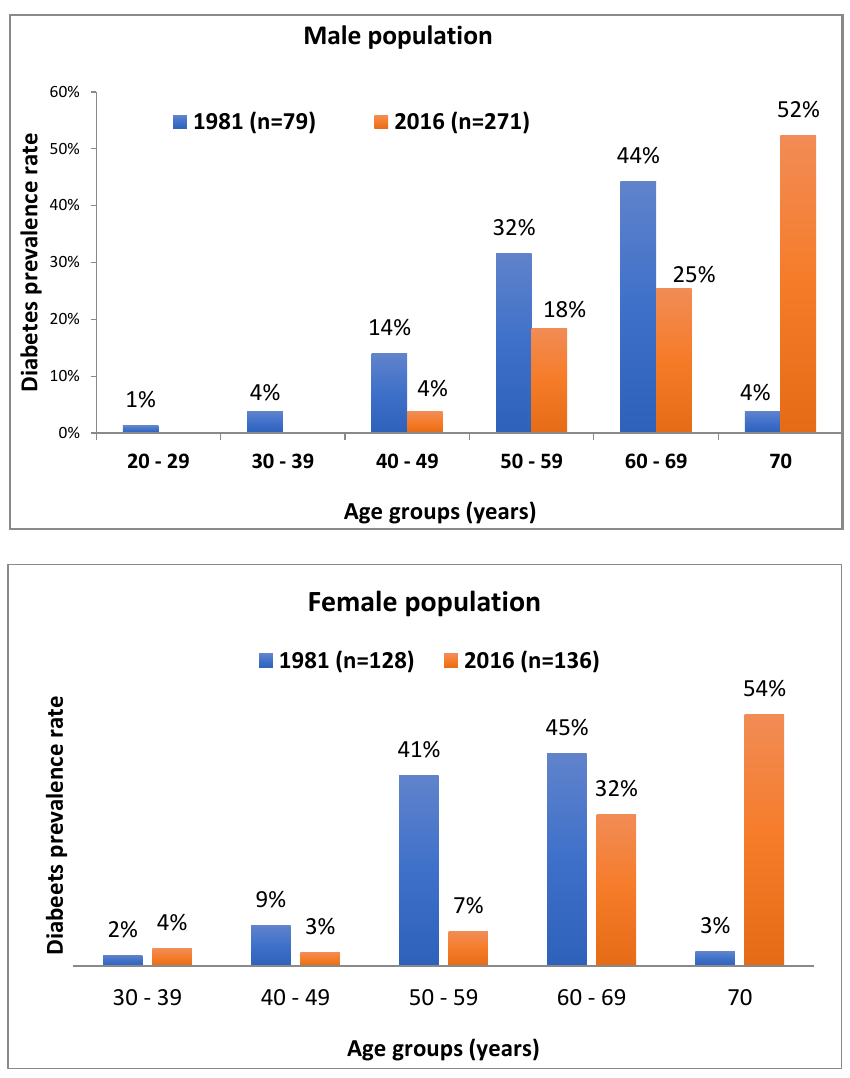
Figure 2. Diabetes prevalence rates amongst the WHO 1981 and SAHHTEK 2014 – 2016 studies, by age groups and